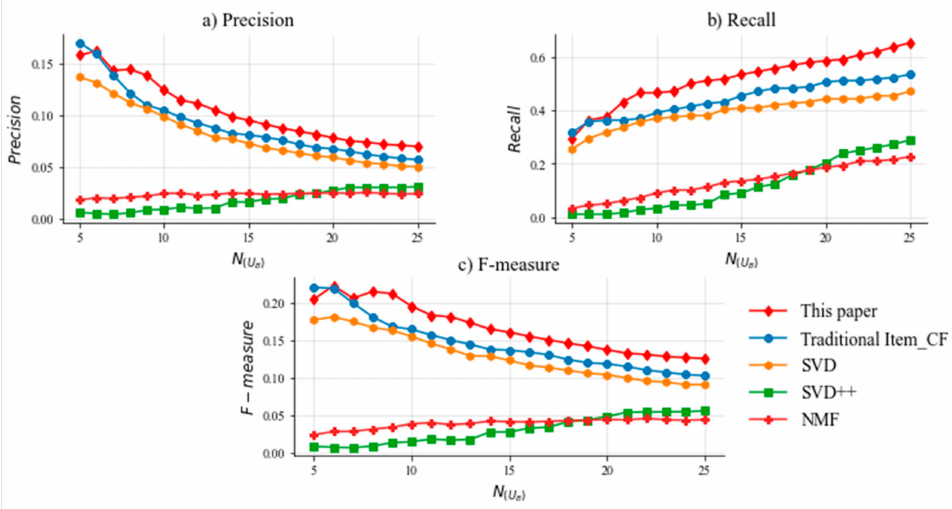
Figure 6. The comparison results of the proposed ReRec approach (the combination of ReRec-IASI and ReRec-IAUSI) and four baselines on inactive